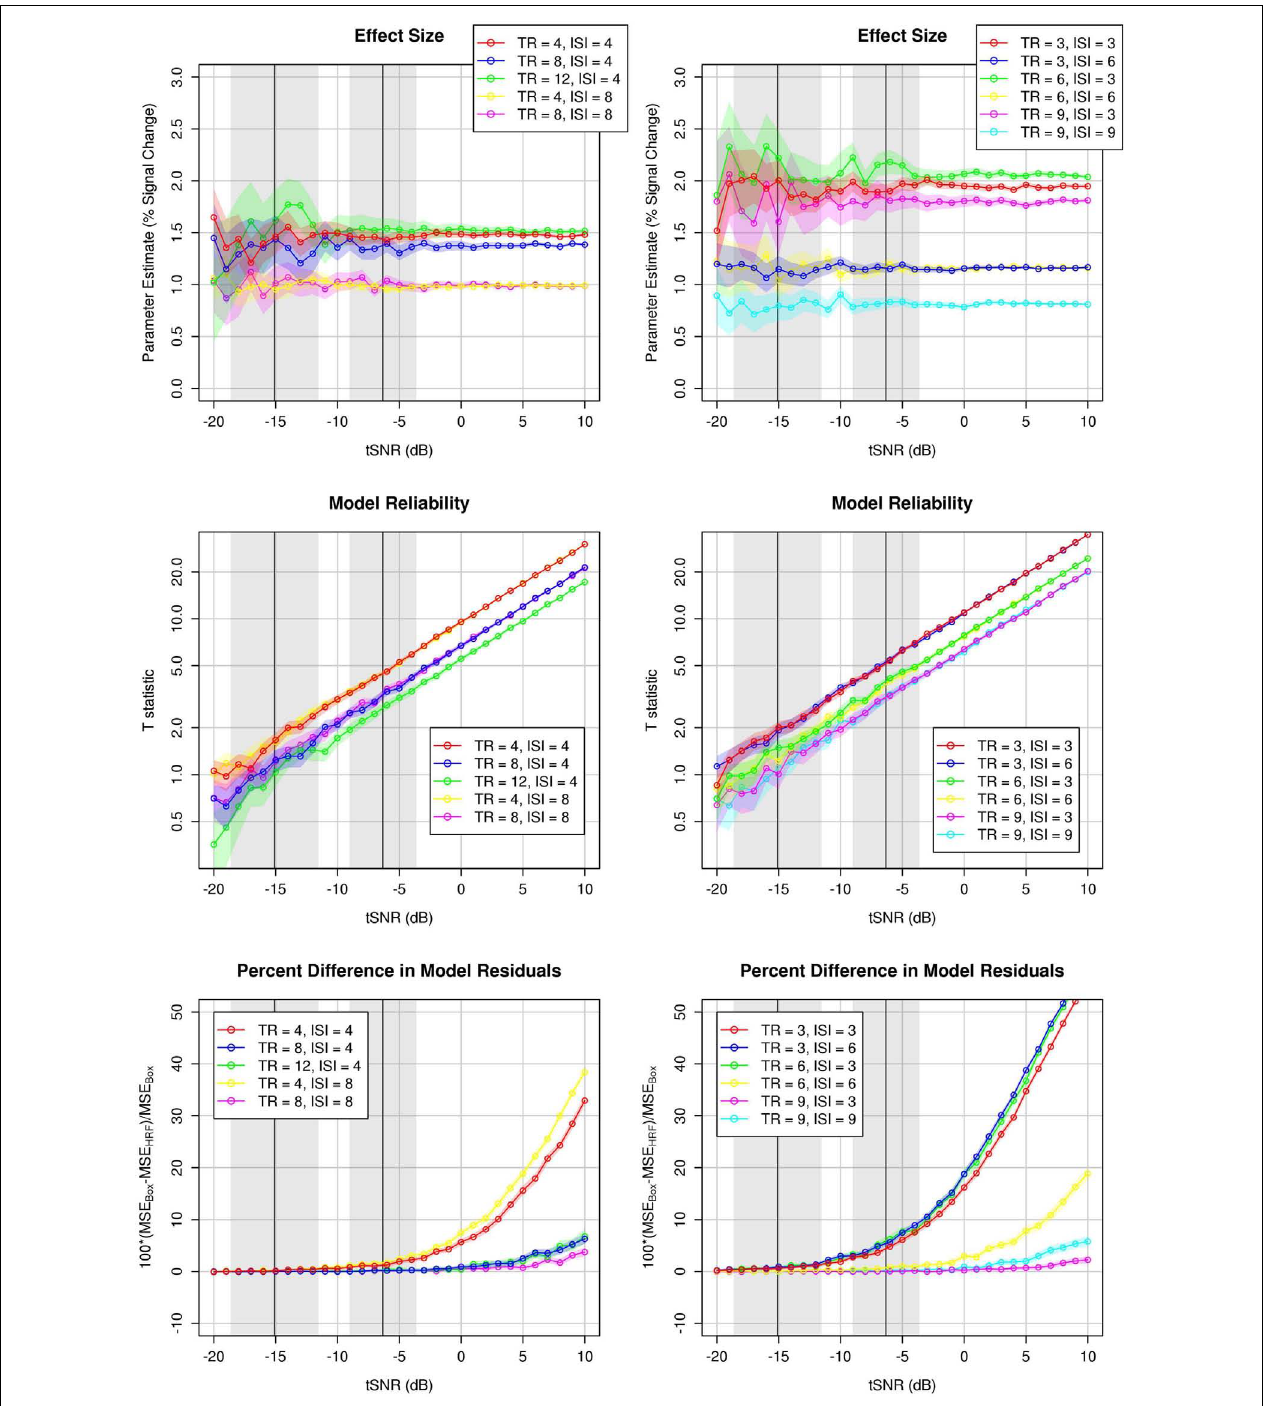
TRs with rapid stimulation, and longTRs with infrequent stimulation, again likely due to the additivity of the BOLD response.The range of actual tSNR values observed in the experimental validation of these results is illustrated in the shaded gray domains: left domain, mean and 95% confidence interval across participants of the mean tSNR within left Heschl’s gyrus; right domain, mean, and 95% confidence interval across participants of the maximum tSNR in left Heschl’s gyrus. Note that the plots showing model reliability are effectively log–log